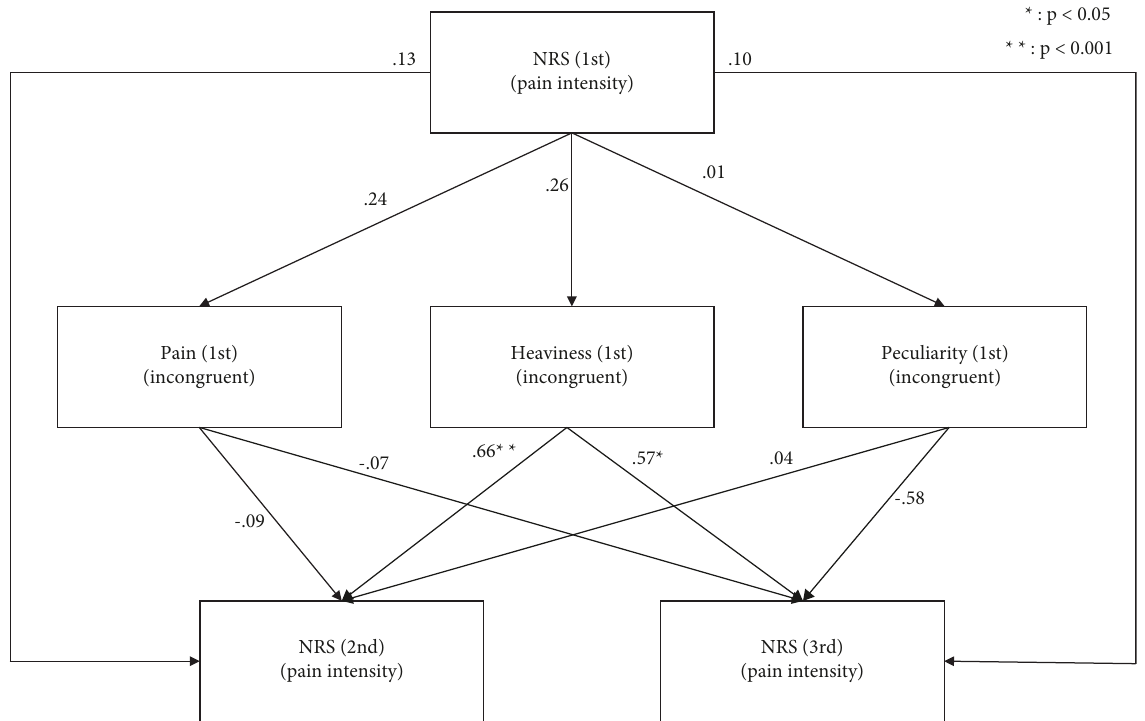
Figure 3: Structural equation model of pain intensity and abnormal perception. A signifcant positive correlation ( p < 0 . 05) was found between the pain intensity (second and third) and heaviness